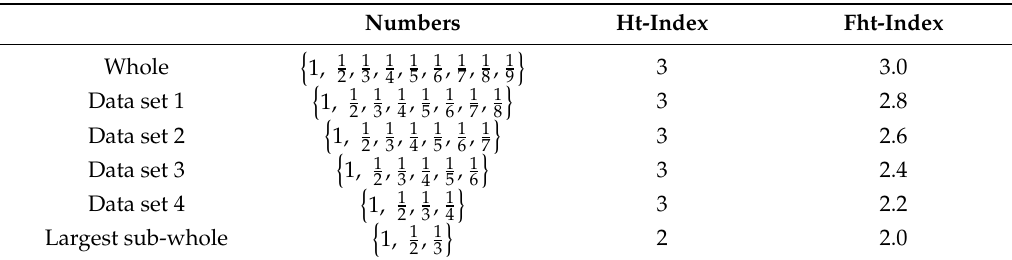
Table 2. Four data sets and their whole, largest sub-whole, ht-index, fht-index.